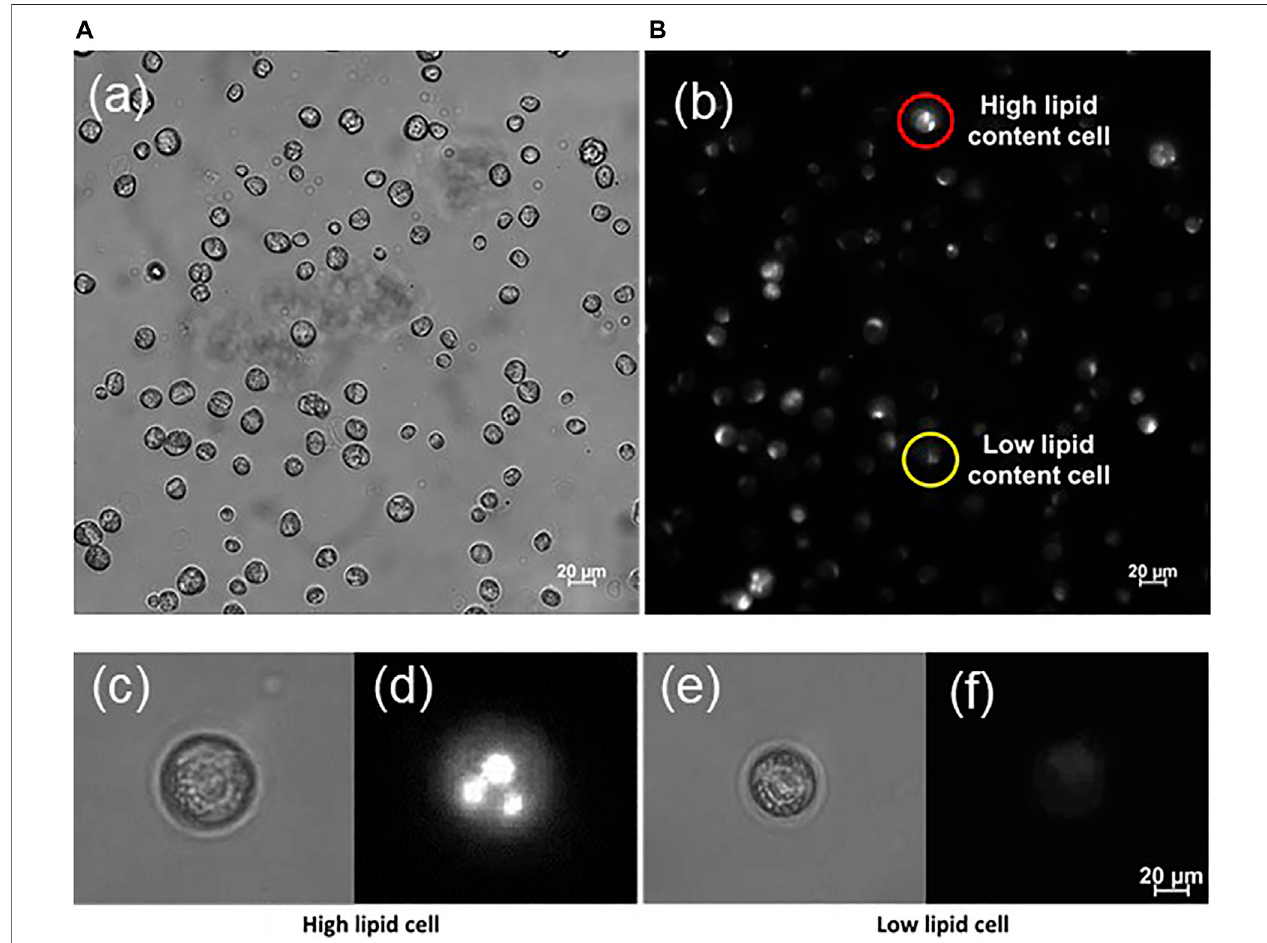
FIGURE4| Microscopicview ofimmobilized C. cohnii cells from cultivation day number 4inbright fi eld (A) and fl uorescence (B) mode. The cells werestained with Nile red dye to visualize their lipid content; Thus, each cell fl uoresces with different intensity according to its lipid content. Cells with high lipid content appear brighter, contrary to the low lipid cells that emit less fl uorescence. In both pictures (A,B) display the same area of the microalgae sample. — (C – F) Typical examples of C. cohnii cells showing high (C,D) and low lipid content (E,F) . The cell ’ s intracellular lipid seems to form droplets.